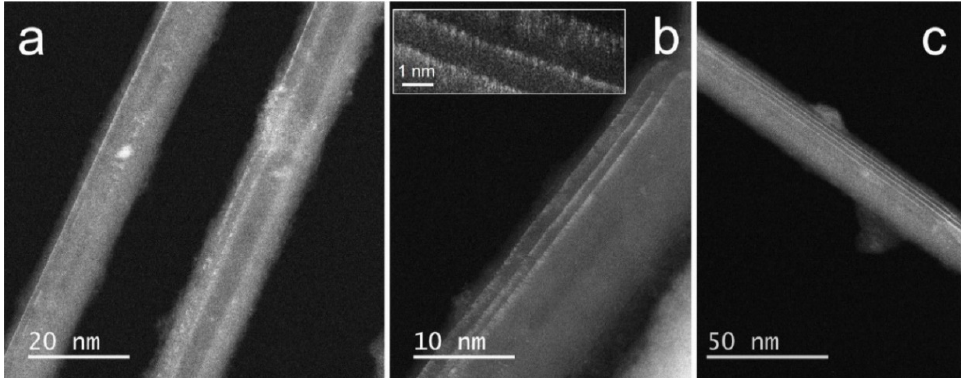
Figure 3. ( a – c ) HAADF images of arc-prepared MWCNTs treated with iodine. Bright contrast is due to the presence of iodine. Lower contrast is that of carbon only. The central cavity width of each MWCNT can be estimated thanks to its darker contrast. The inset in ( b ) is an enlarged detail from the image underneath, oriented differently.